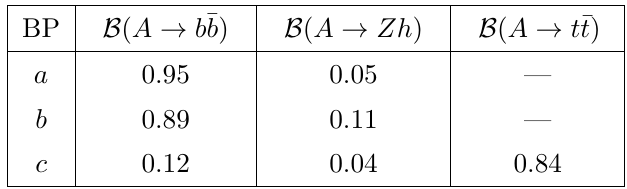
Table 2 . Branching ratios of A for the benchmark points in table 1 with Re ( ρ bb ) = 0 . 0 , | Im ( ρ bb ) | = 0 . 15 and | ρ tt | = 0 . 5